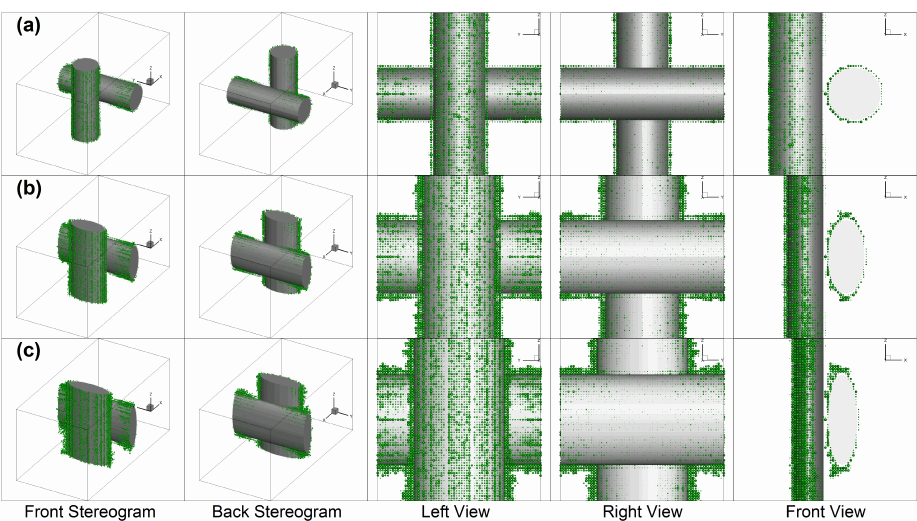
Figure 7 Figure 7. Dendrite structures with different aspect ratios: ( a ) Case 5, ε = 1; ( b ) Case 2, ε = 2; ( c ) Case 6, ε = 3.